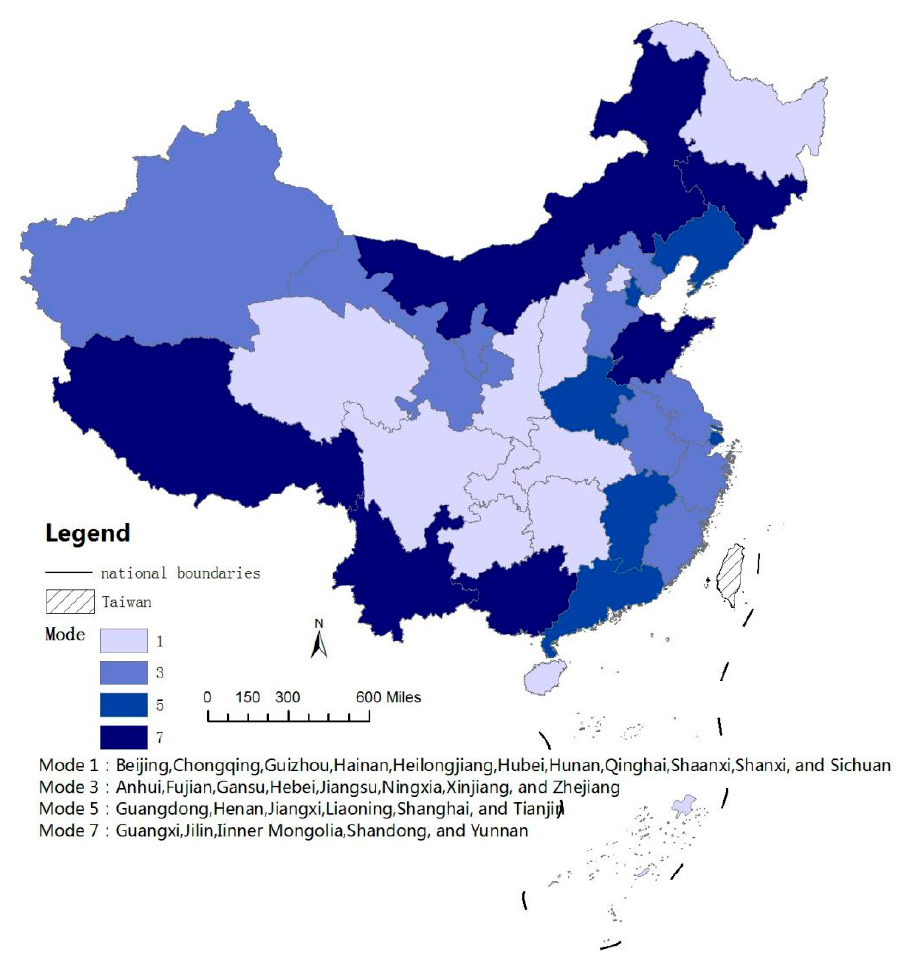
Figure 4. The Transport Development Mode Map for China’s 30 Provinces and Municipalities.